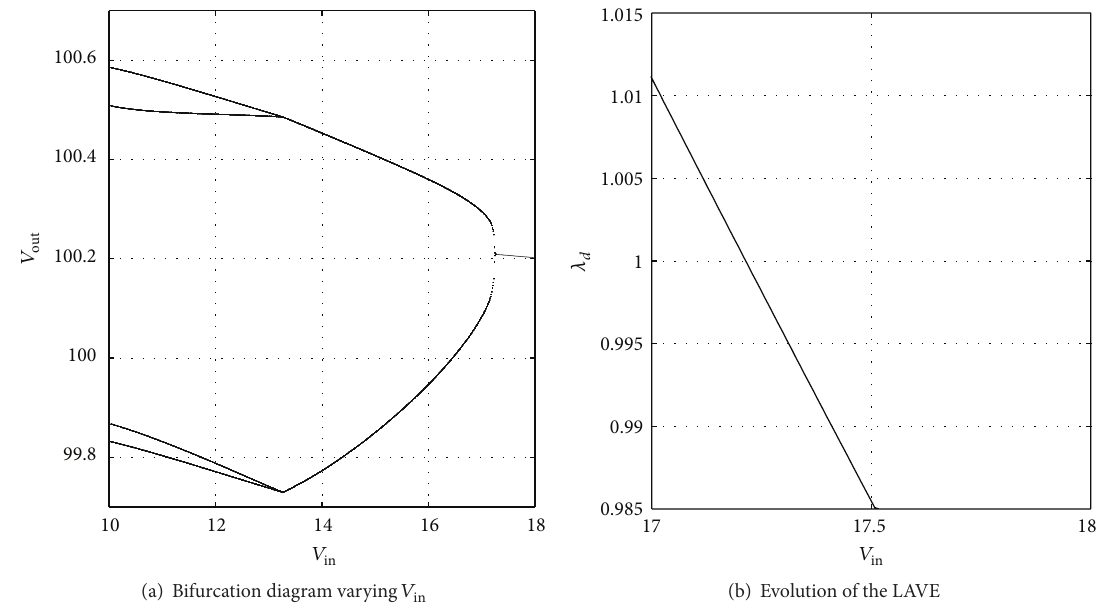
Figure 5: Steady state and stability of period-1 orbit as 𝑉 in varies in [10,18] V.